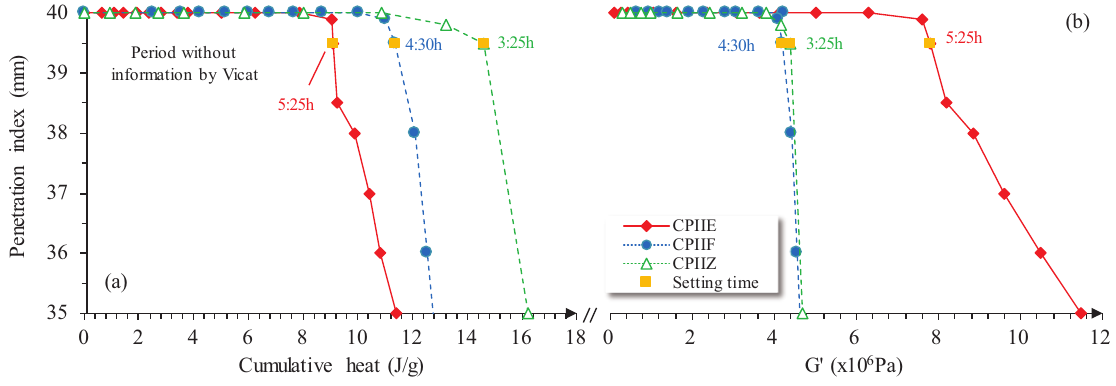
Relationship between penetration index monitored by Vicat test and cumulative heat accompanied by isothermal calorimetry. The setting times of each paste are